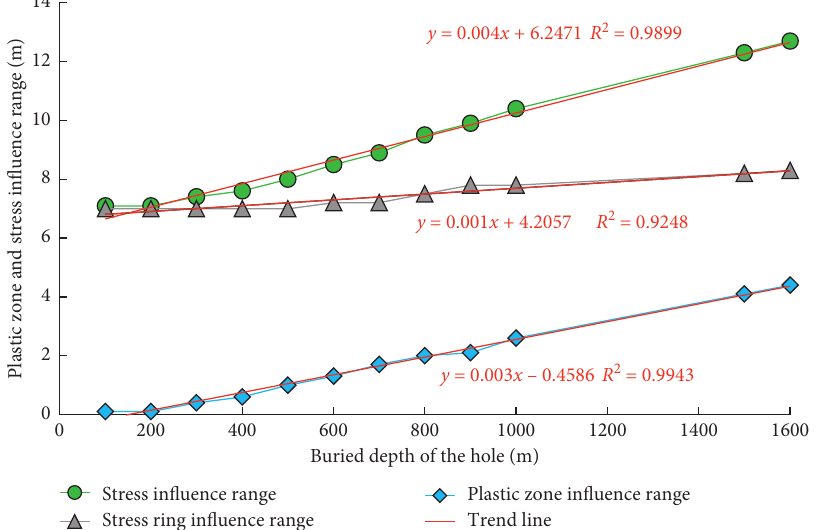
Figure 7: Relationship between the plastic zone of holes in the surrounding rock and the influence range of